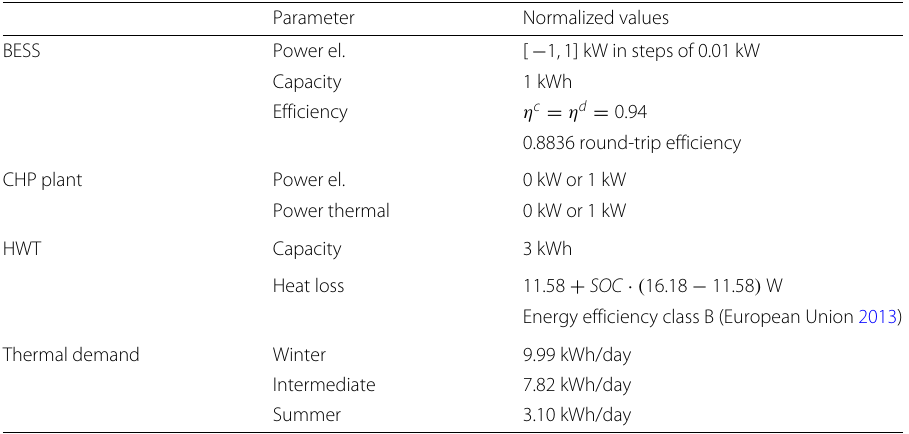
Table 1 Overview of the model parameters. The parameters for the BESS and the CHP plant have been normalized individually. Thermal consumption, the hot water tank capacity, and losses have been divided by 6 in order to scale them to a size appropriate for the normalized CHP plant Parameter Normalized values BESS Power el.